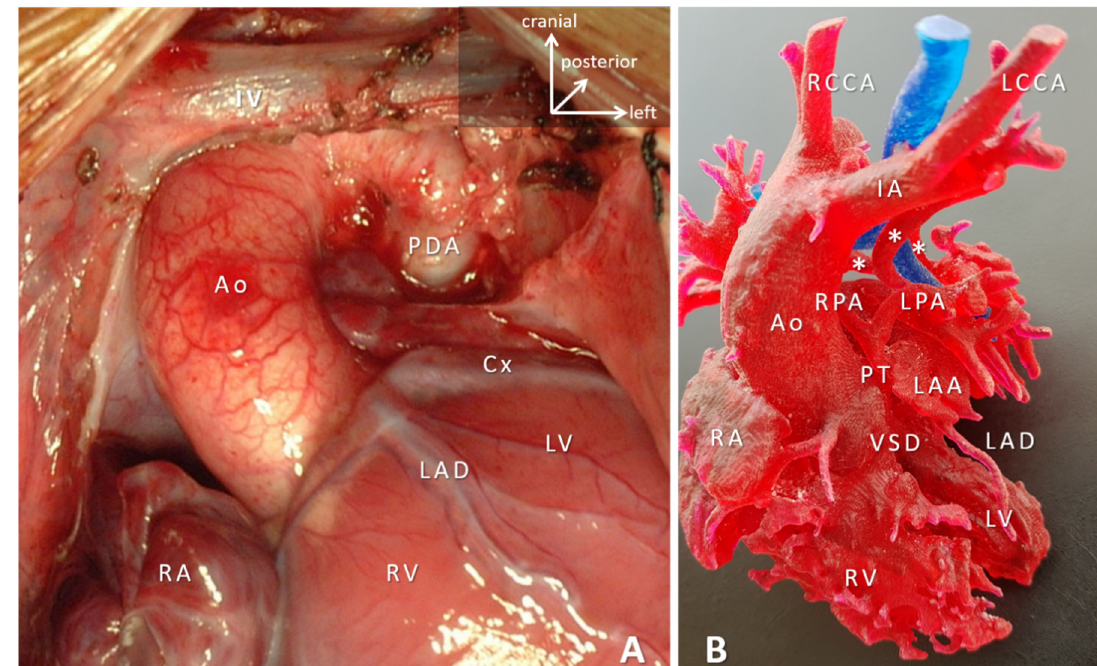
Figure 3. ( A ) Intraoperative representation of pulmonary atresia with absent intrapericardial pulmonary arteries. Ascending aorta (Ao) is the only outlet from the heart. Patent arterial duct (PDA) perfuses the left pulmonary artery (not visible). Left atrial appendage is retracted to expose the left coronary artery system (LAD: left anterior descending and Cx: circumflex branches). ( B ) 3D-printed blood-volume model of pulmonary atresia, VSD and major aortopulmonary collaterals arteries (MAPCAs); right aortic arch. The right ventricle outflow tract is missing and the native pulmonary arteries are hypoplastic. Majority of the pulmonary circulation depends on the MAPCAs (*). Surgical planning is grossly supported by a detailed 3D-printed models. In both cases, the paramount surgical task involves reconstruction of the intrapericardial pulmonary arteries and connecting them to the right ventricle via a preferably valved and growing conduit. Abbreviations: AO: ascending aorta; Cx: circumflex branch of the left coronary artery; IA: innominate artery; IV: innominate vein; LAA: left atrial appendage; LAD: left anterior descending branch of the left coronary artery; LCCA: left common carotid artery;